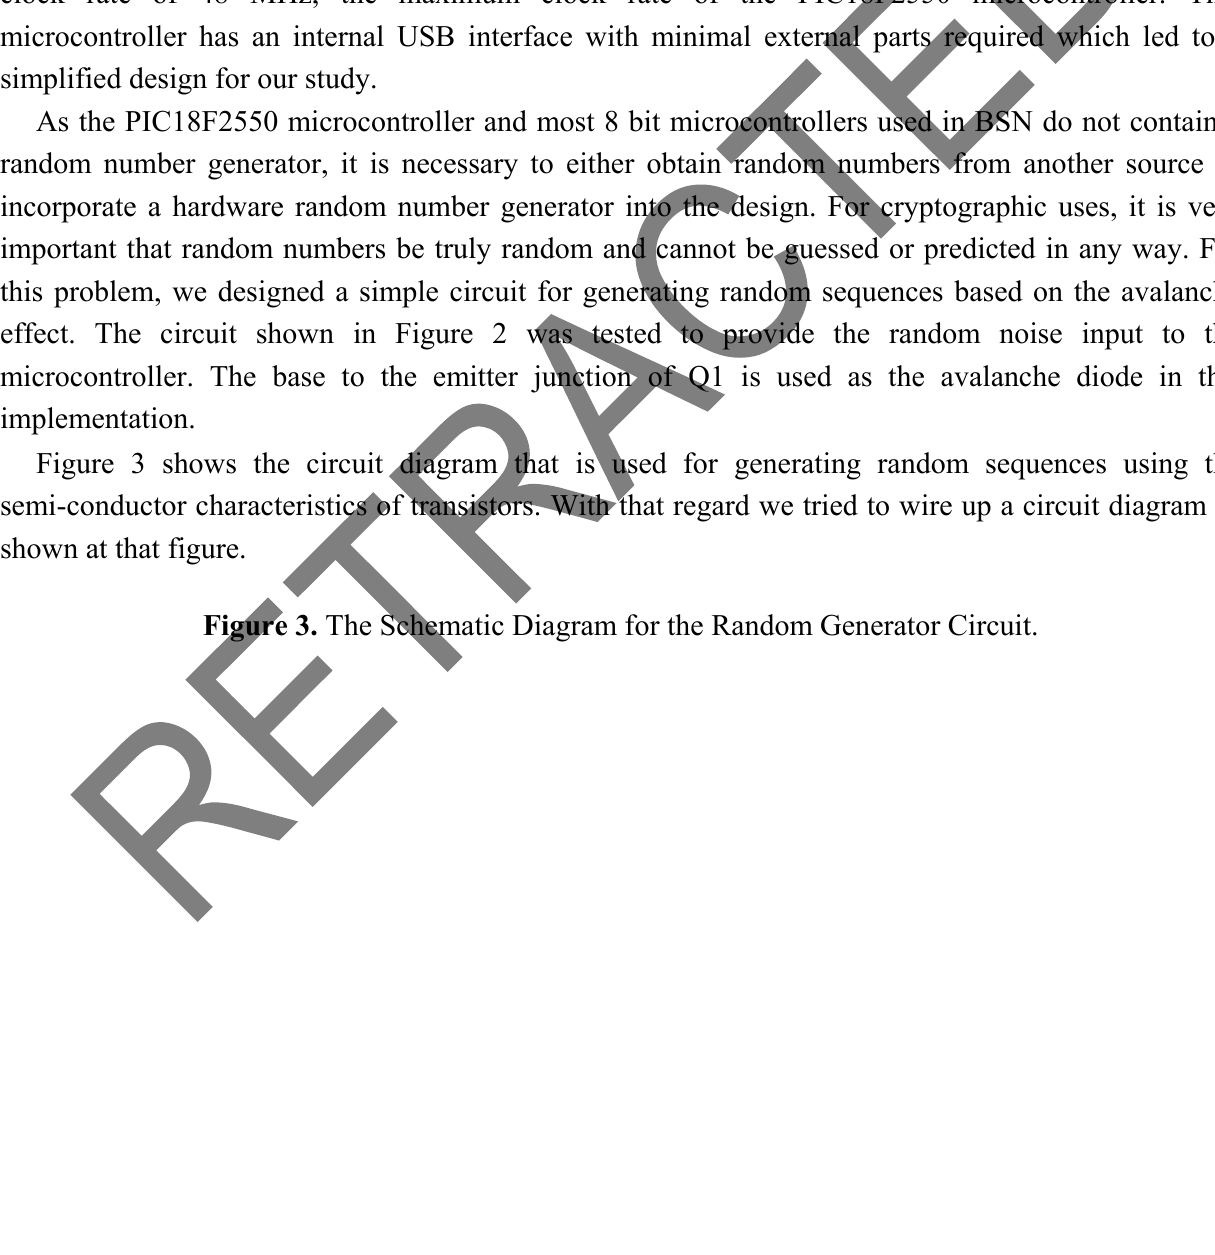
Figure 3. The Schematic Diagram for the Random Generator